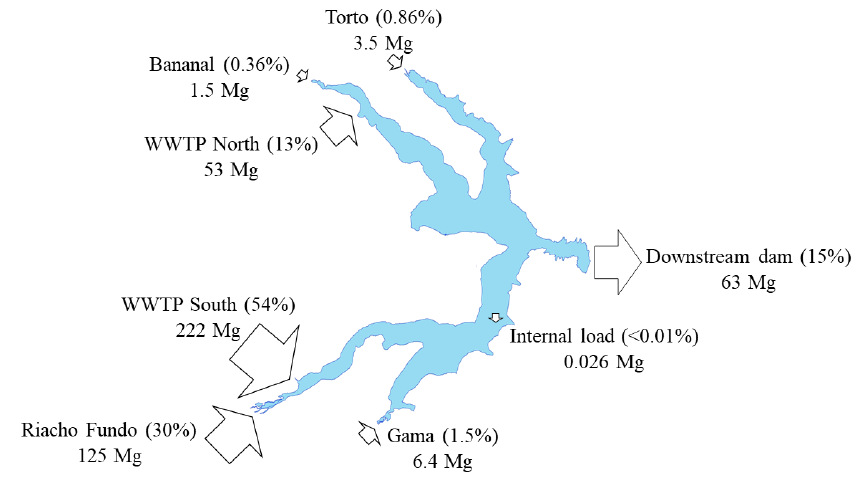
Figure 6. Annual dissolved inorganic nitrogen (DIN) budget for Lake Parano á .